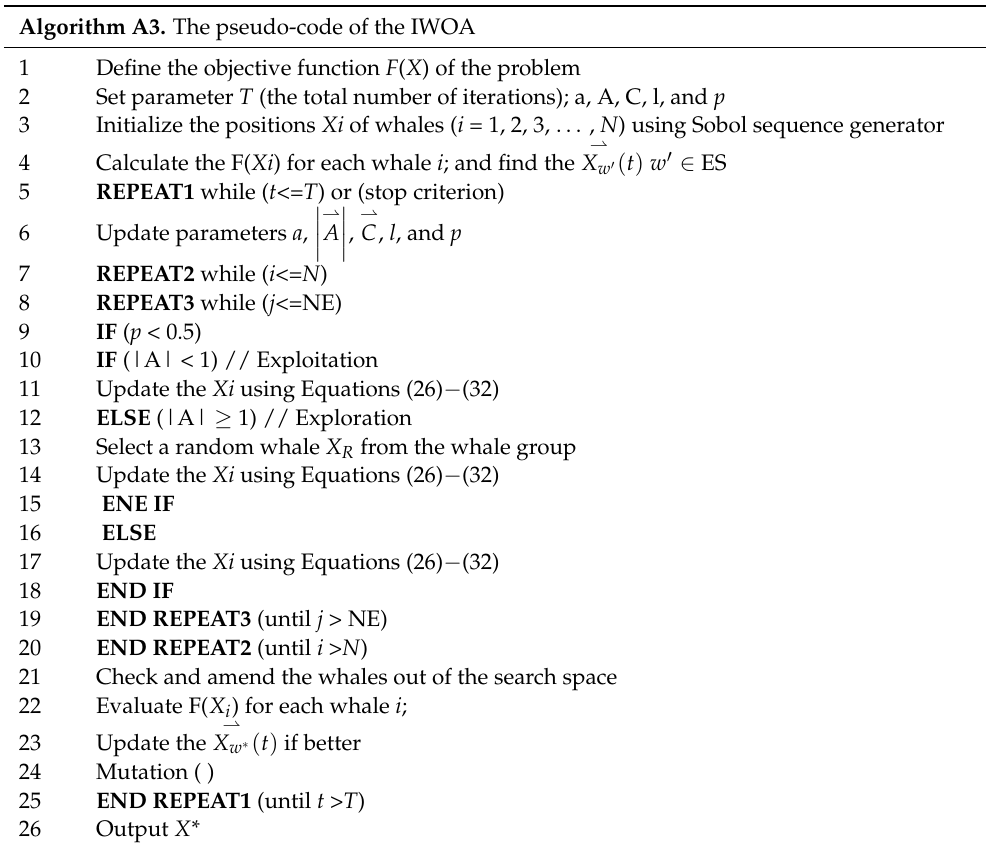
Algorithm A3. The pseudo-code of the